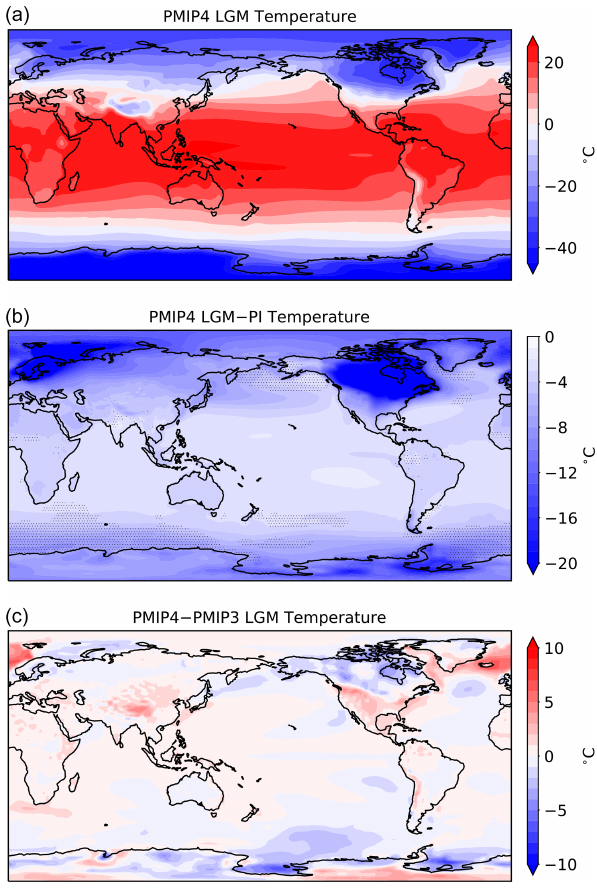
Figure 3. Same as Fig. 2 but for the 250hPa zonal wind. The PMIP4 average is based on all models listed in Table 1. The PMIP3 average is based on all PMIP3 models in Table 1, except the GISS- E2-p151 simulation, which did not use the PMIP3 ice sheet for its boundary